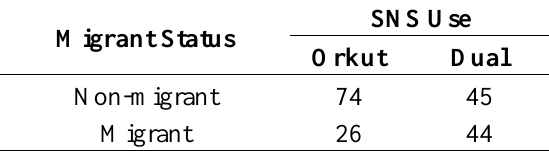
Table 5. Sample Composition, Study 2, by migrant status and SNS in